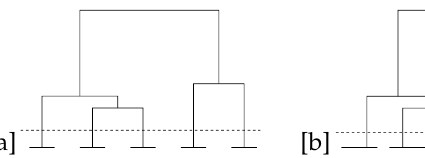
Figure 5. Hierarchical clustering of prototypes. Coordinates of each cluster prototype are represented with respect to the x-axis.